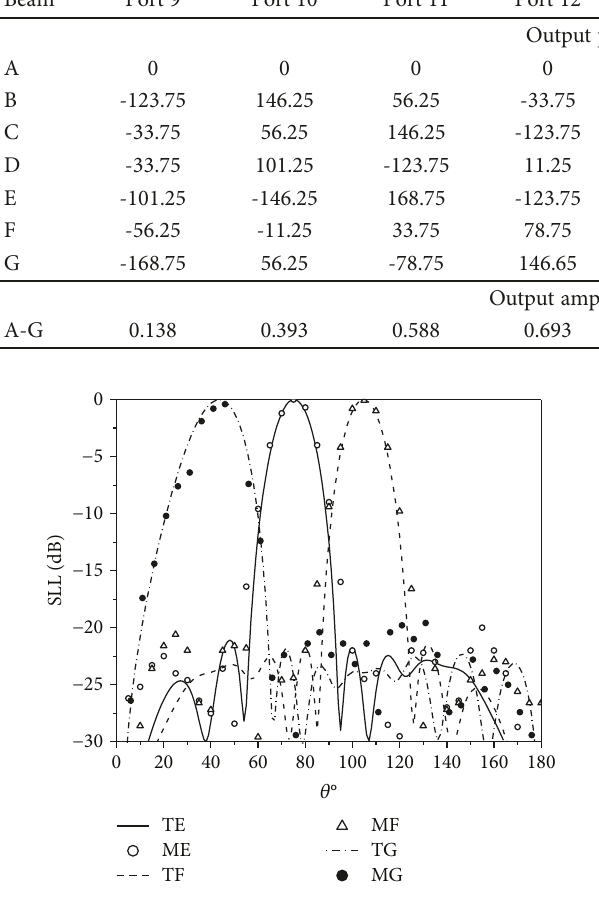
Table 5: Outputs and phase progressions β Beam